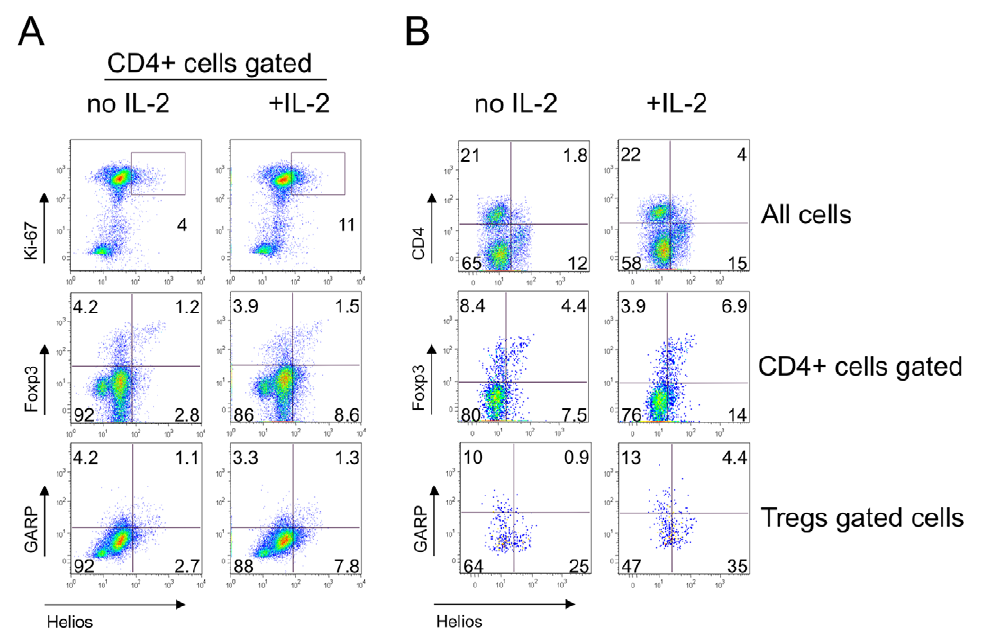
Figure 6. IL-2 increased Helios expression in Ki-67 + Foxp3- GARP- cells. Murine MNC from lymph nodes and spleen (A) and human PBMC (B) were stimulated with CD3/CD28 6 IL-2 for 24 hrs and stained for CD4, Foxp3, Helios, Ki-67 and GARP. IL-2 addition led to a slight increase in expression of Helios by Ki-67 + (A, top) CD4 + and CD4- (B, top) and Foxp3- cells (A, B, middle rows). Helios expression was not associated with GARP expression in CD4 + gated (A, bottom) or Foxp3 + gated (B, bottom)